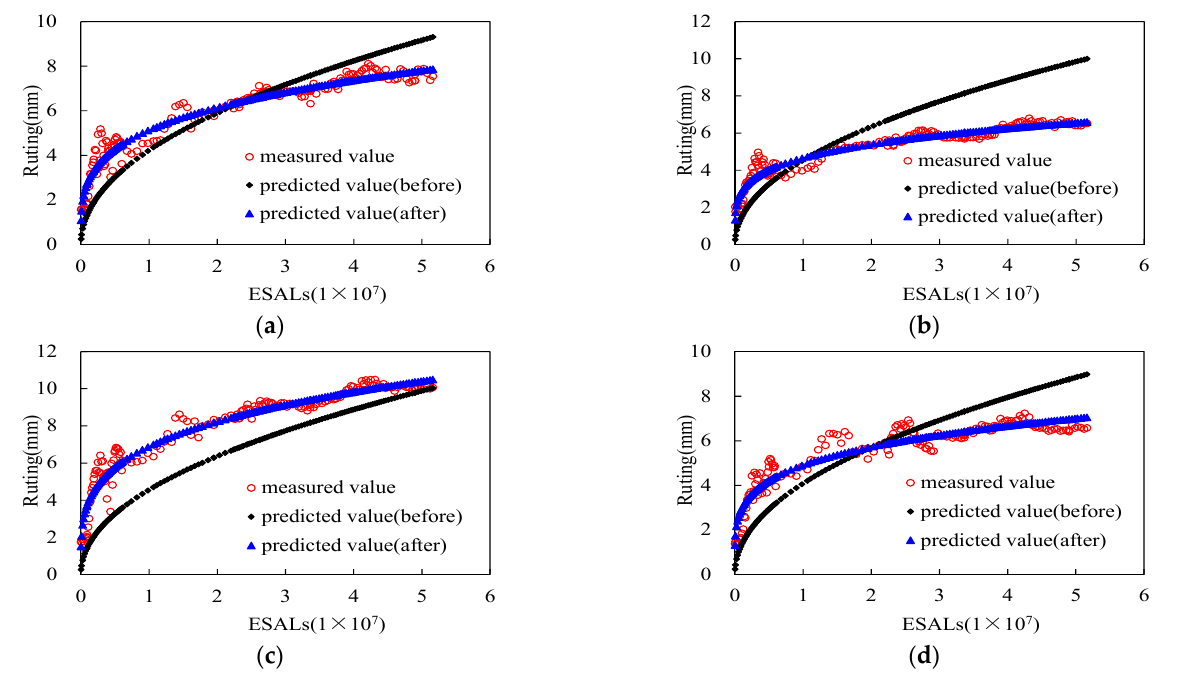
Figure 7. Comparison of predicted and measured values before and after rutting model correction.